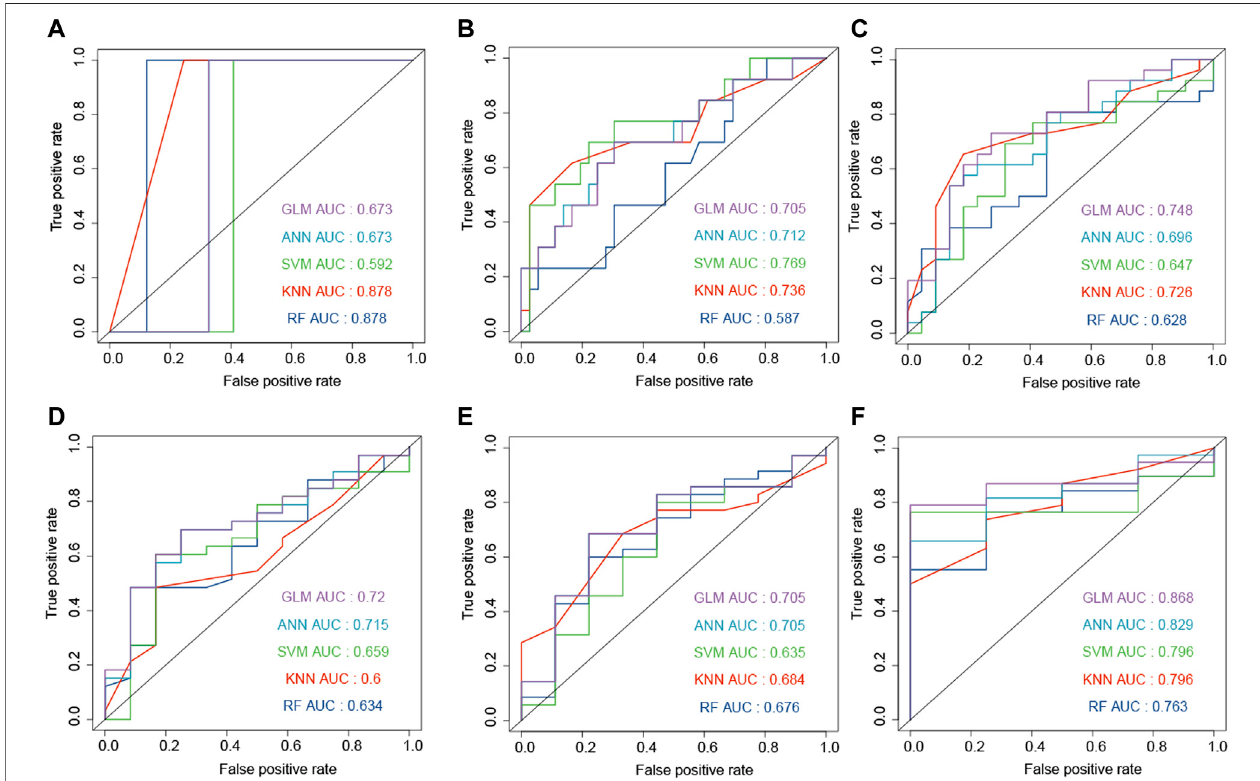
FIGURE 6 | Development and evaluation of the machine learning models to predict the survival status at 6 (A) , 12 (B) , 18 (C) , 24 (D) , 30 (E) , and 36 (F) months based on gender, age, and ECM genes (AEBP1, F3, FLNC, IGFBP2, and LDHA). These AUC results were calculated on the independent dataset (GSE83300).